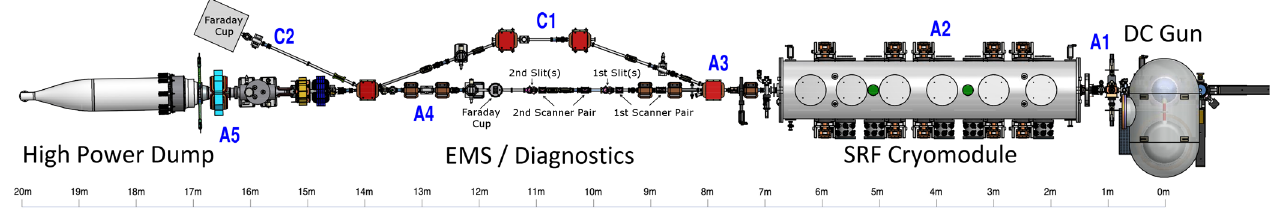
FIG. 1. Top view of the Cornell injector. The deflecting cavity (not shown) is located between the second EMS slit pair and the A4 Faraday